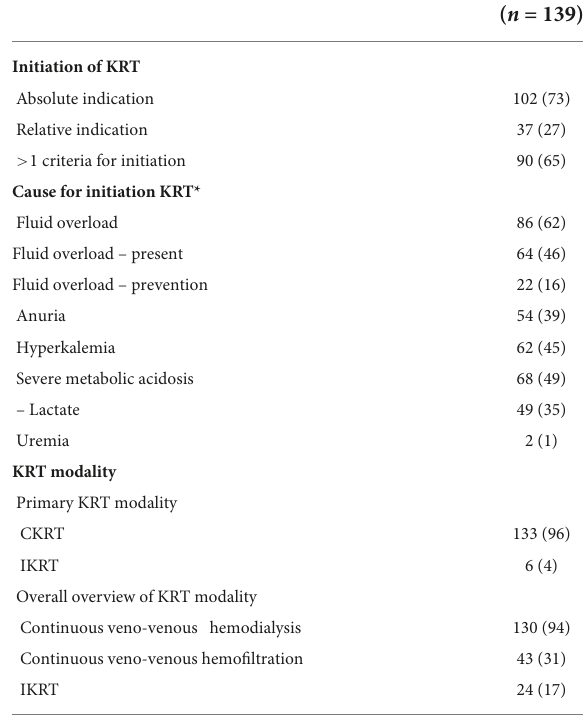
TABLE 1 Baseline demographic and clinical characteristics on ICU admission.